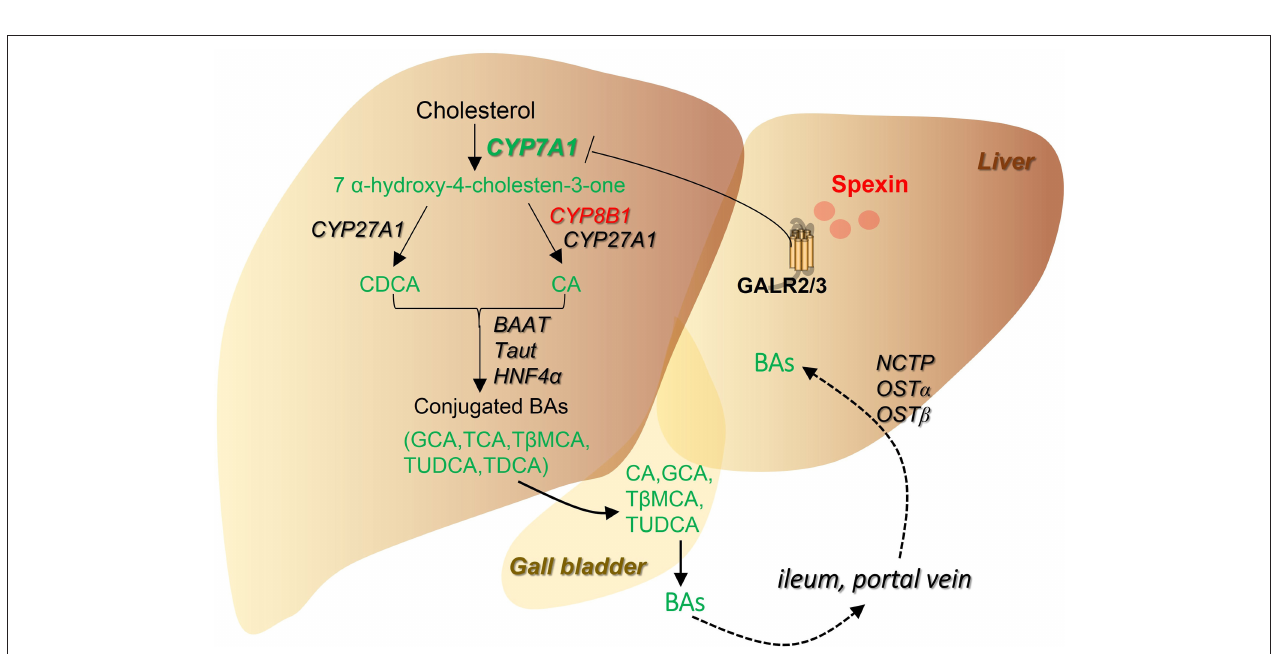
FIGURE 8 | Summarized scheme for the regulation of spexin on bile acid pathway. Changes of the metabolites and genes were highlighted (Red, increased; Green, decreased). Spexin downregulates bile acid synthesis by suppressing CYP7A1 expression, resulting in a decrease of total bile acid pool in the enterohepatic circulation.